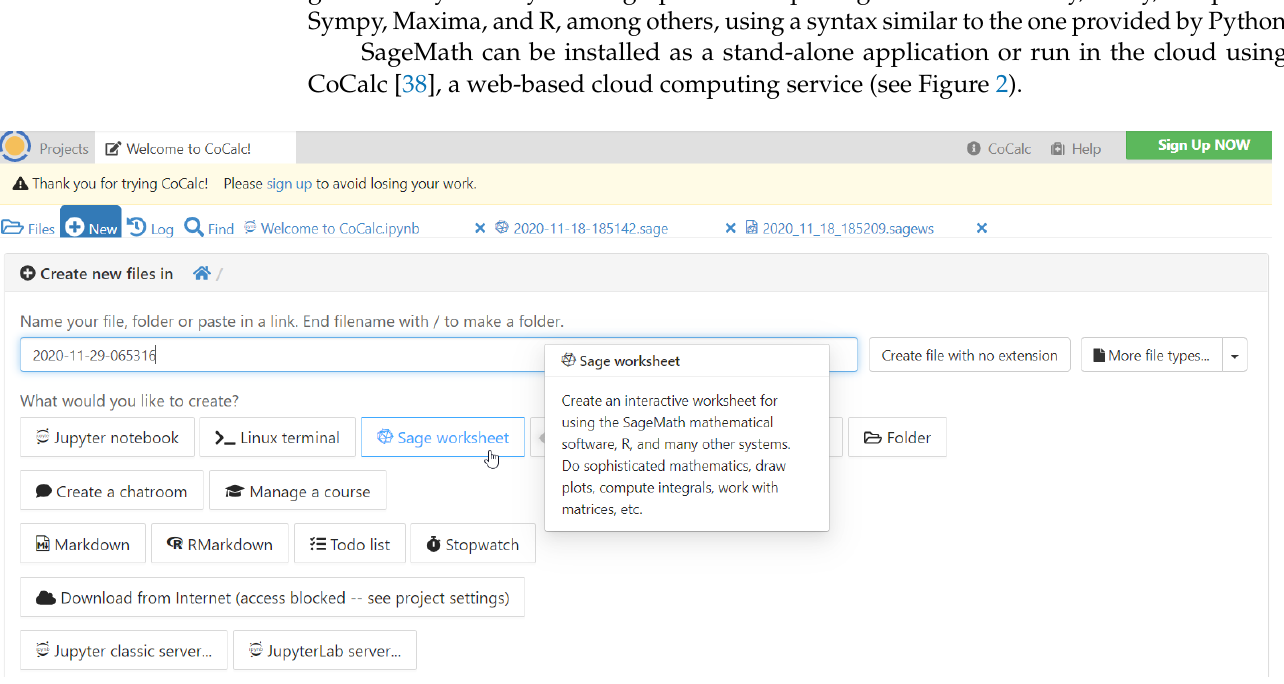
Figure 2. CoCalc